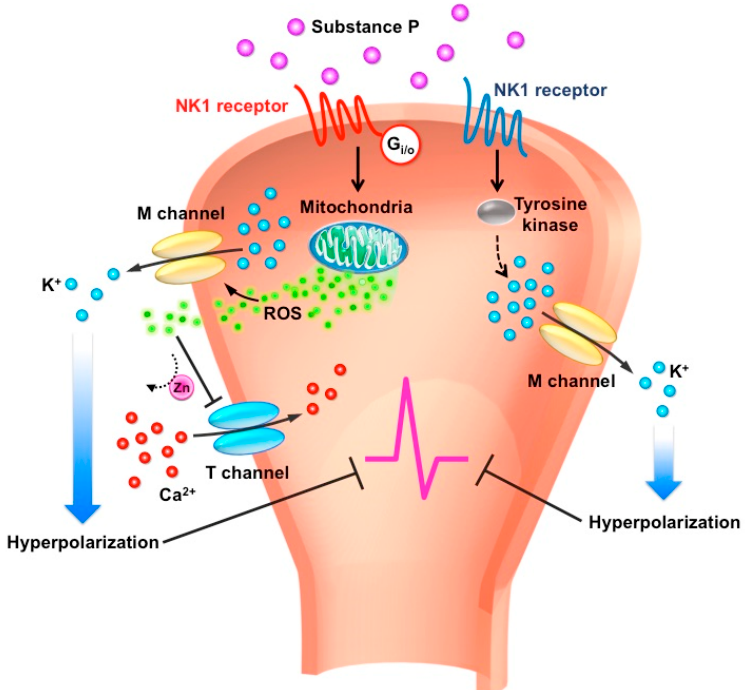
Figure 1. Schematic diagram of substance P-mediated signaling and ion channels in the peripheral sensory neurons. Release of substance P (SP) in the nerve terminal acts on neurokinin 1 receptor (NK1R) via two different effector systems modulating M-type K + and T-type Ca 2+ channels. First, activated NK1R coupled to tyrosine kinase augments the M-type potassium channels, resulting in neuronal hyperpolarization. Second, activated NK1R coupled to G i/o triggers reactive oxygen species (ROS) release from mitochondria simultaneously to augment M-type potassium channels and inhibit T-type calcium channels, which inhibits neural firing in peripheral sensory neurons.